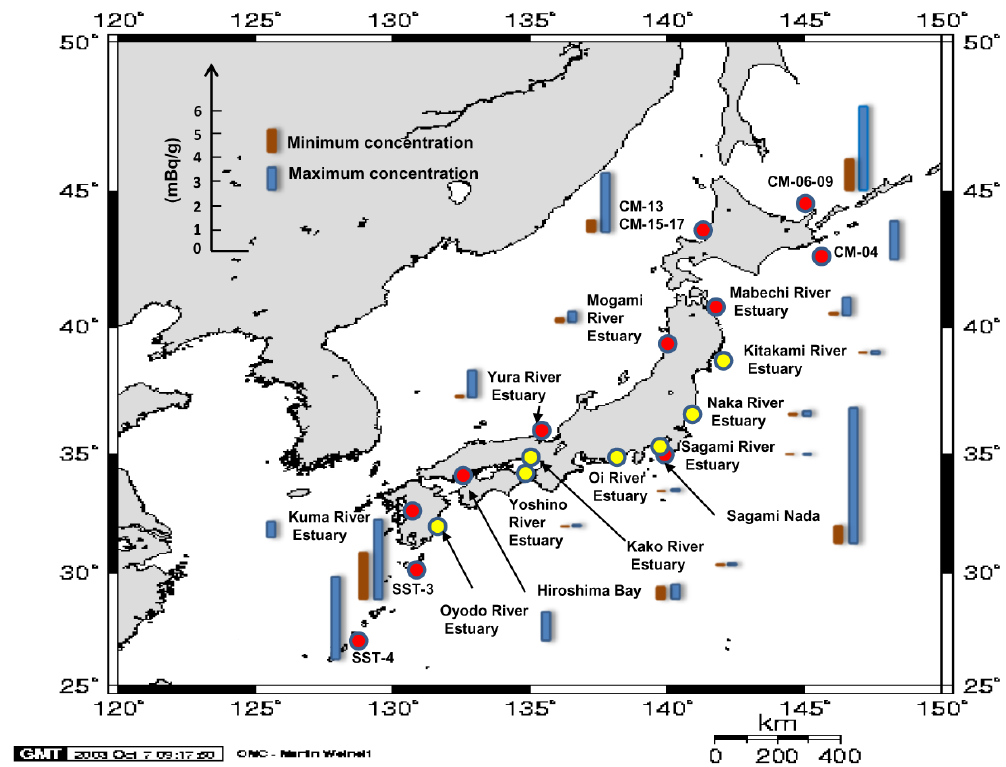
Fig. 1. Map showing the Japanese estuaries and the Pu concentration (mBqg − 1 ) in the surface sediments (0–2cm) in the Japanese near-coast marine environment. The yellow circled sites represent the sampling sites in this study. The red circled sites are from the literature (NIRS, 2010; Zheng and Yamada, 2005, 2006b, c). The surface sediment Pu concentration range was between 0.003–5.81mBqg − 1